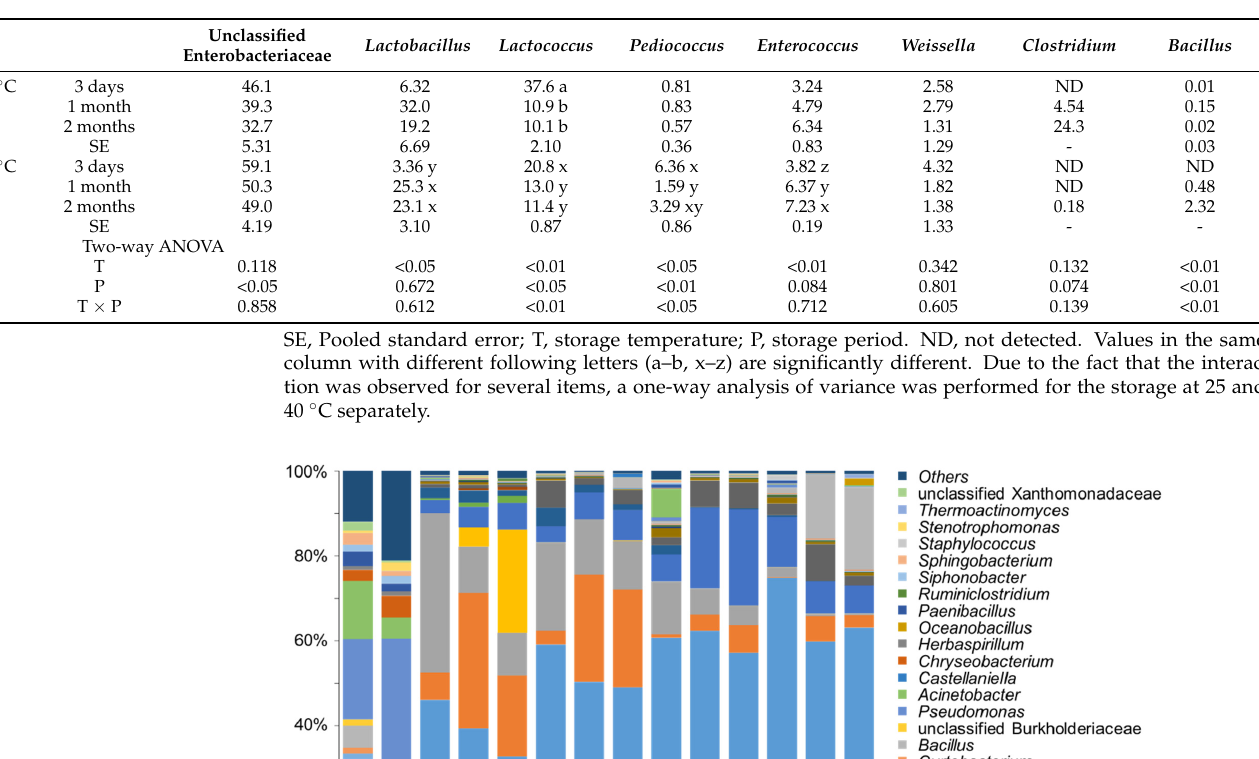
Table 3. Relative abundances (%) of the eight most abundant bacterial genera in direct-cut guinea grass silage stored at 25 and 40 °C for 3 days, 1 month, and 2 months.